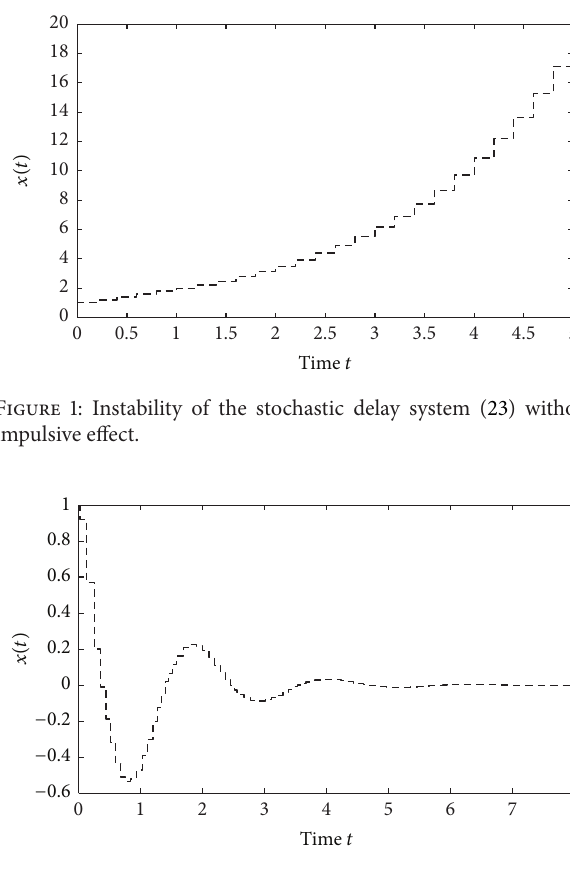
Figure 2: Impulsive Stabilization of the stochastic delay system